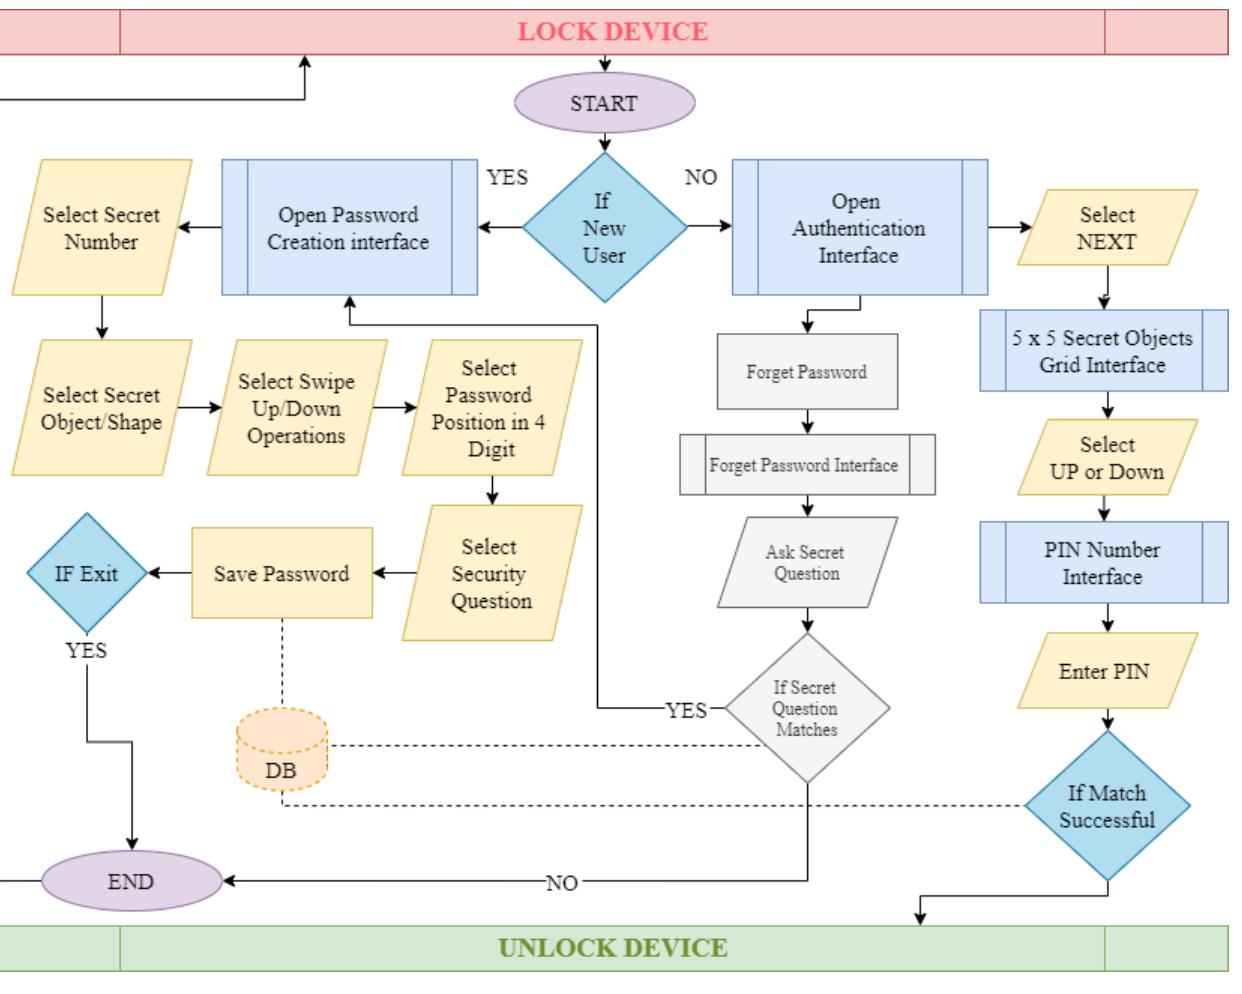
Figure 8. Data flow diagram of